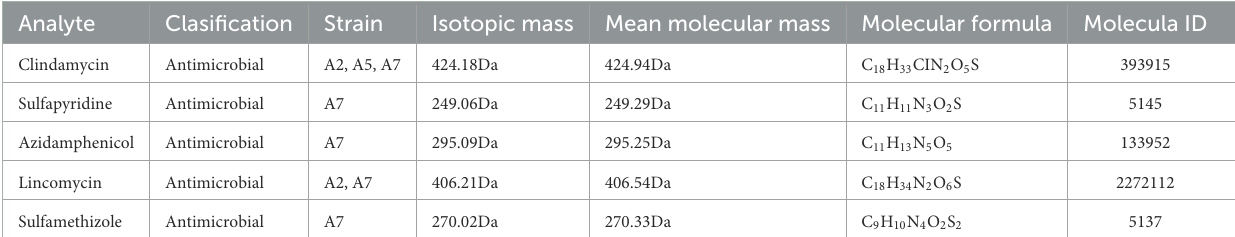
TABLE 2 Analytes detected after the chromatogram carried out on the acellular extracts of strains Microbacterium barkeri A2; Cellulosimicrobium funkei A5; and Cellulosimicrobium cellulans A7 concentrated in